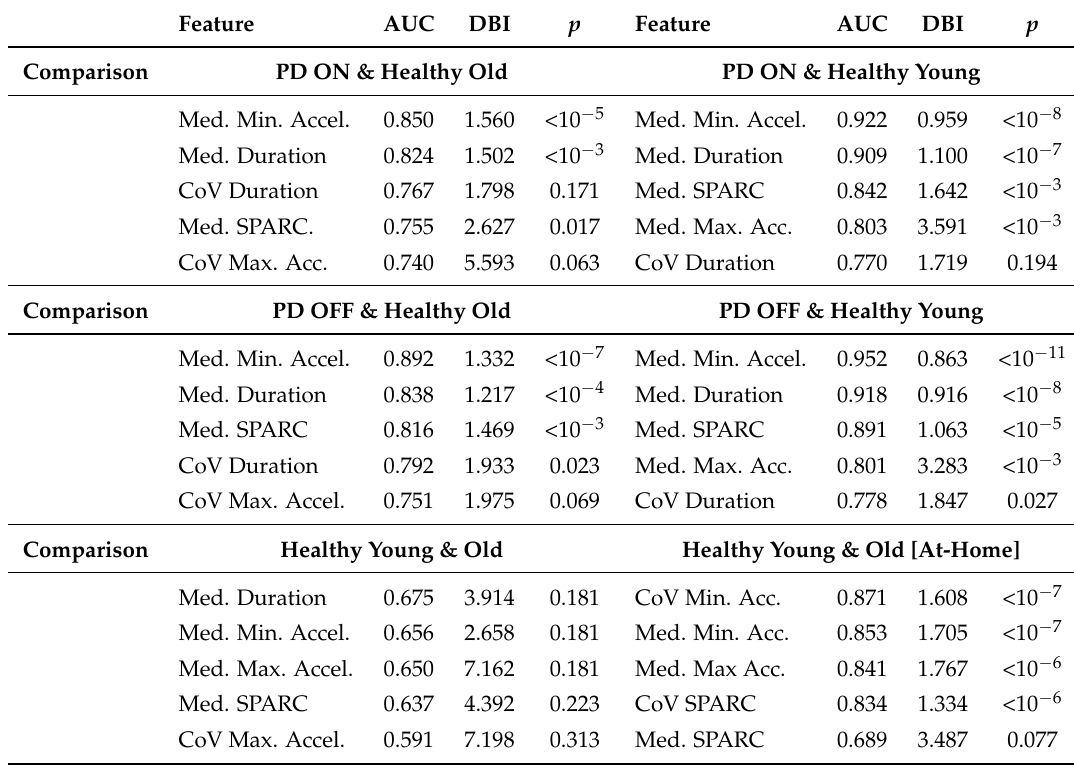
Table 4. Top 1 five features with best performing STS metrics for assessing separation and classification of the compared participant groups. Comparison is based on all detected transfers per subject during the corresponding studies. All data are from in-lab, unless noted otherwise. In-lab data were from 26 PwPD, 29 healthy old participants, 31 healthy young participants using the proposed displacement method. At-home data were from 32 healthy old participants, 33 healthy young participants, using the proposed displacement + stillness method.